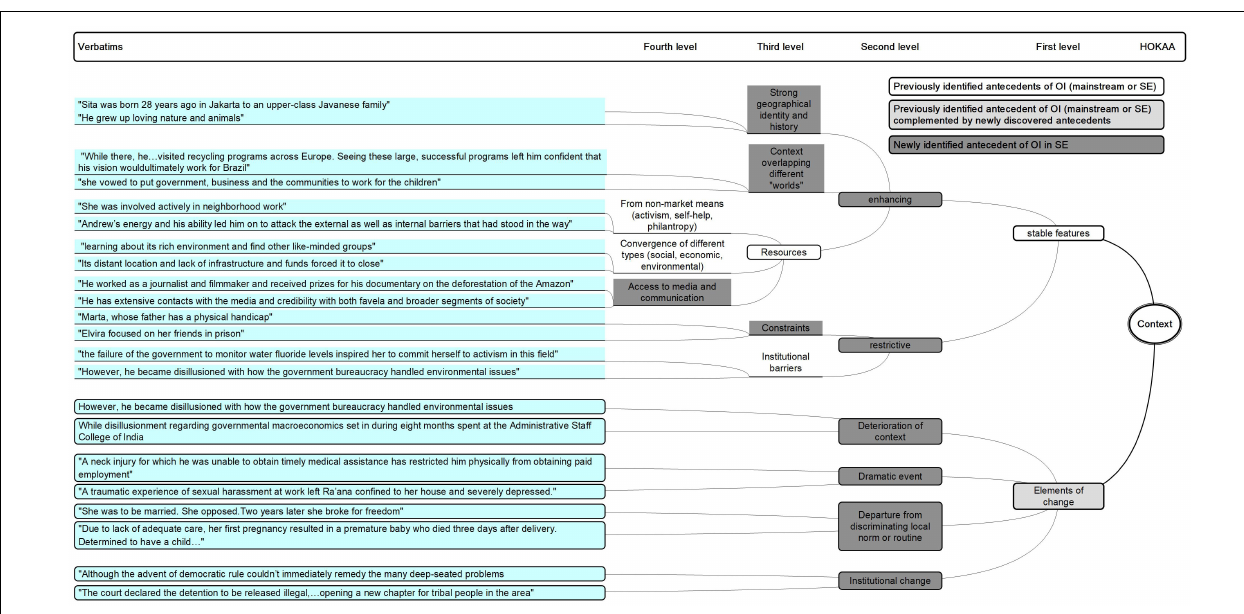
FIGURE 2 | HOKAA ‘Context’: emerging